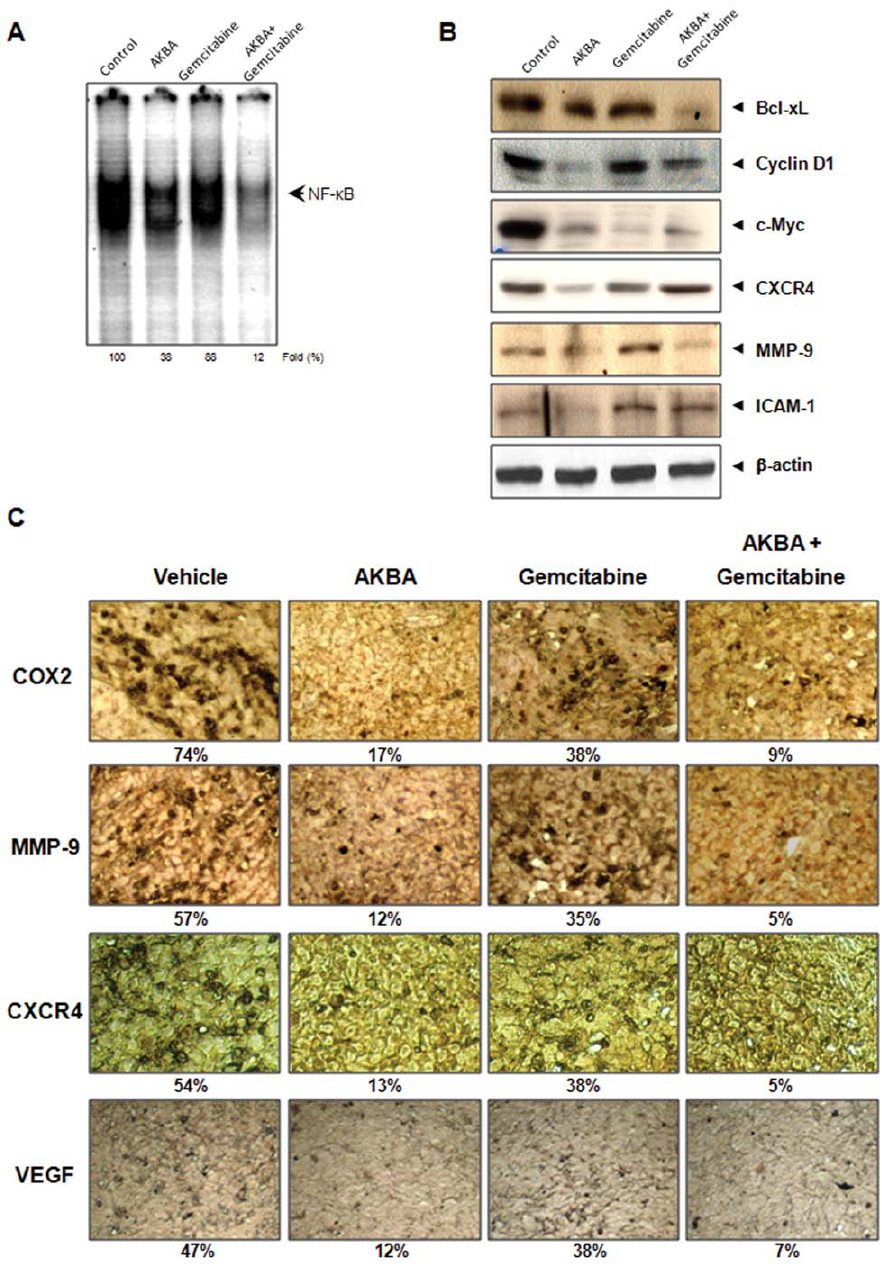
Figure 5. AKBA enhances the effect of gemcitabine against the expression of NF- k B and NF- k B–regulated gene products in pancreatic cancer tissues. A, detection of NF- k B by DNA binding in orthotopic tumor tissue samples showed the inhibition of NF- k B by AKBA. B, Western blot analysis showed that AKBA alone or combination with gemcitabine inhibited the expression of NF- k B–dependent genes. C, immunohistochemical analysis of NF- k B–regulated genes (COX-2, MMP-9, CXCR4 and VEGF) in pancreatic tumor tissues from mice. Percentages indicate positive staining for the given biomarker. Samples from three animals in each group were analyzed, and representative data are shown.